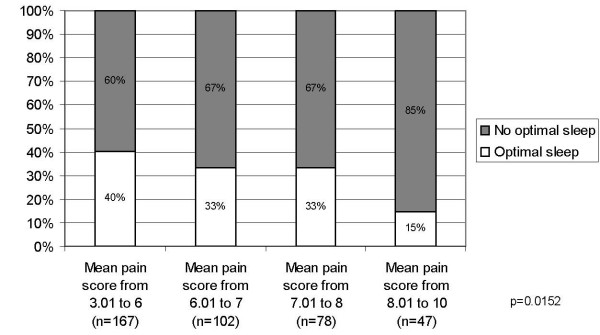
Percentage of patients with optimal sleep according to the mean pain score at baseline; p: chi-square p-value for between-group comparison.